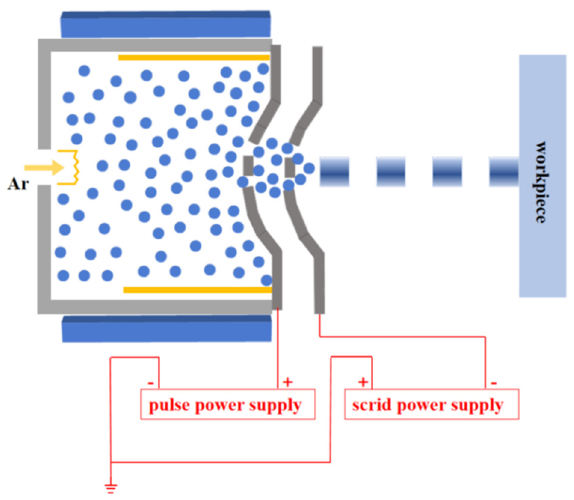
Figure 2. Principle diagram of pulsed ion beam extraction.